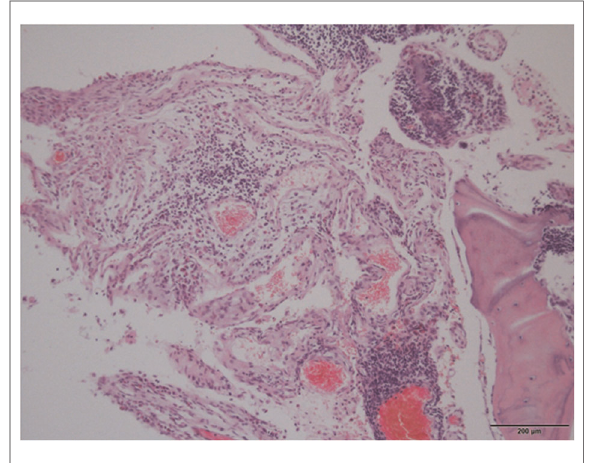
FIGURE 4 The proliferating fi brous tissues and numerous thin-walled blood vessels in the bone cavity are visible in histological pictures of the removed thoracic vertebrae, but there is no sign of cellular atypia or osteogenesis